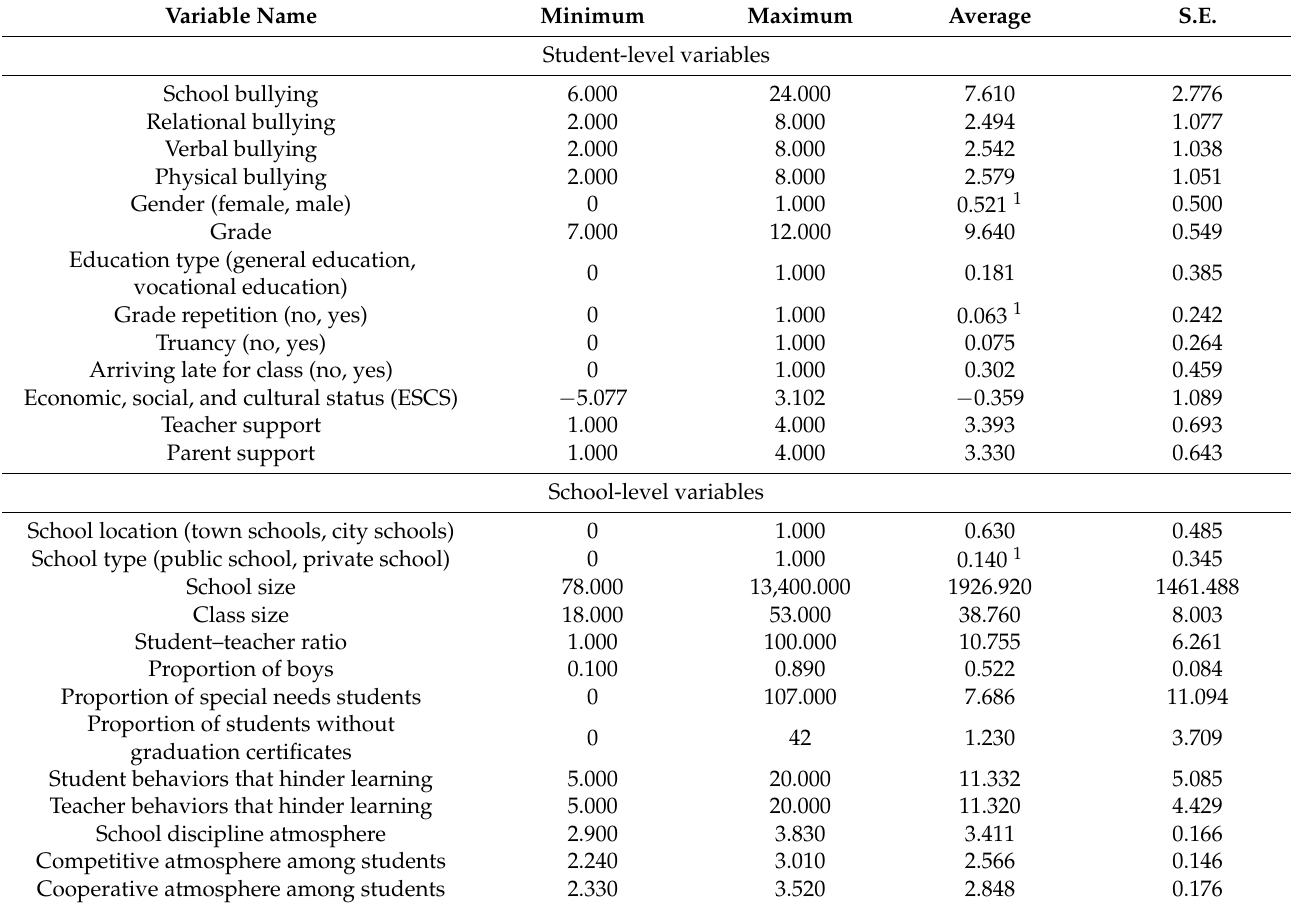
Table 1. Descriptive statistics of the